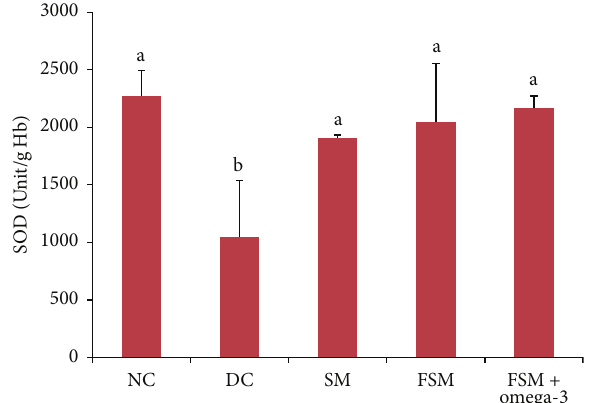
Figure 2: SOD concentrations within the five groups. NC = normal control, DC = diabetic control, SM = diabetic rats that received soymilk, FSM = diabetic rats that received fermented soymilk, and FSM + omega-3 = diabetic rats that received fermented soymilk fortified with omega-3. Each value is expressed as mean ± SD. Values with different letters are significantly different at 𝑃 < 0.05 as analyzed by Duncan’s multiple range test.